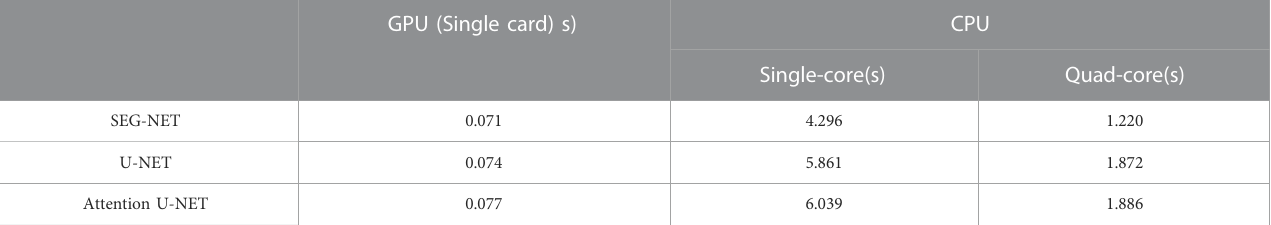
TABLE 7 Running time of deep learning